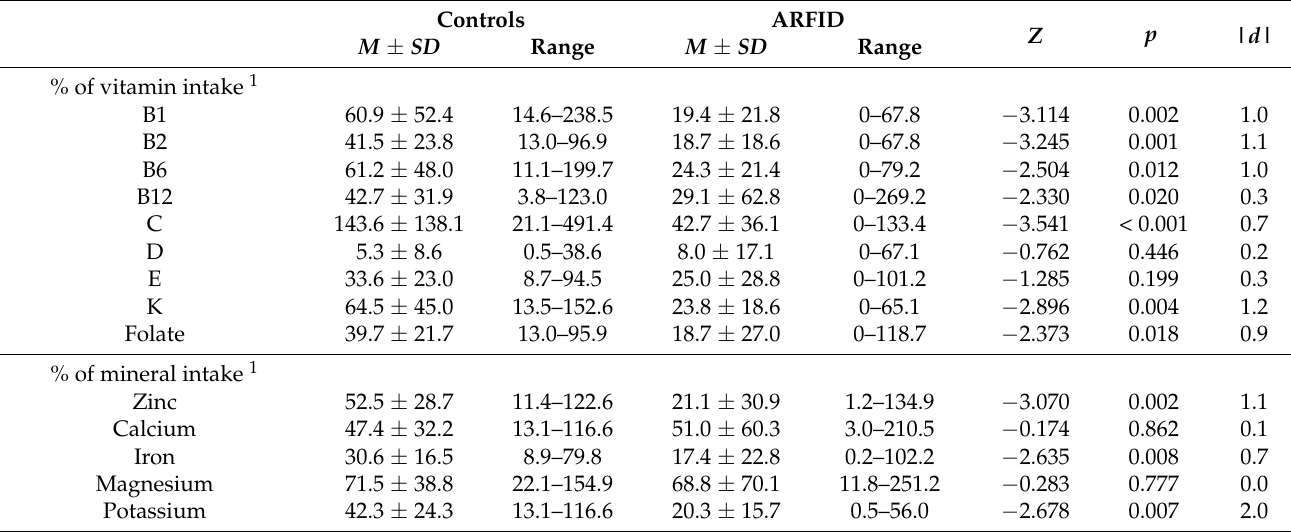
Table 2. Achieved percentage of recommended vitamin and mineral intake in avoidant/restrictive food intake disorder (ARFID) and